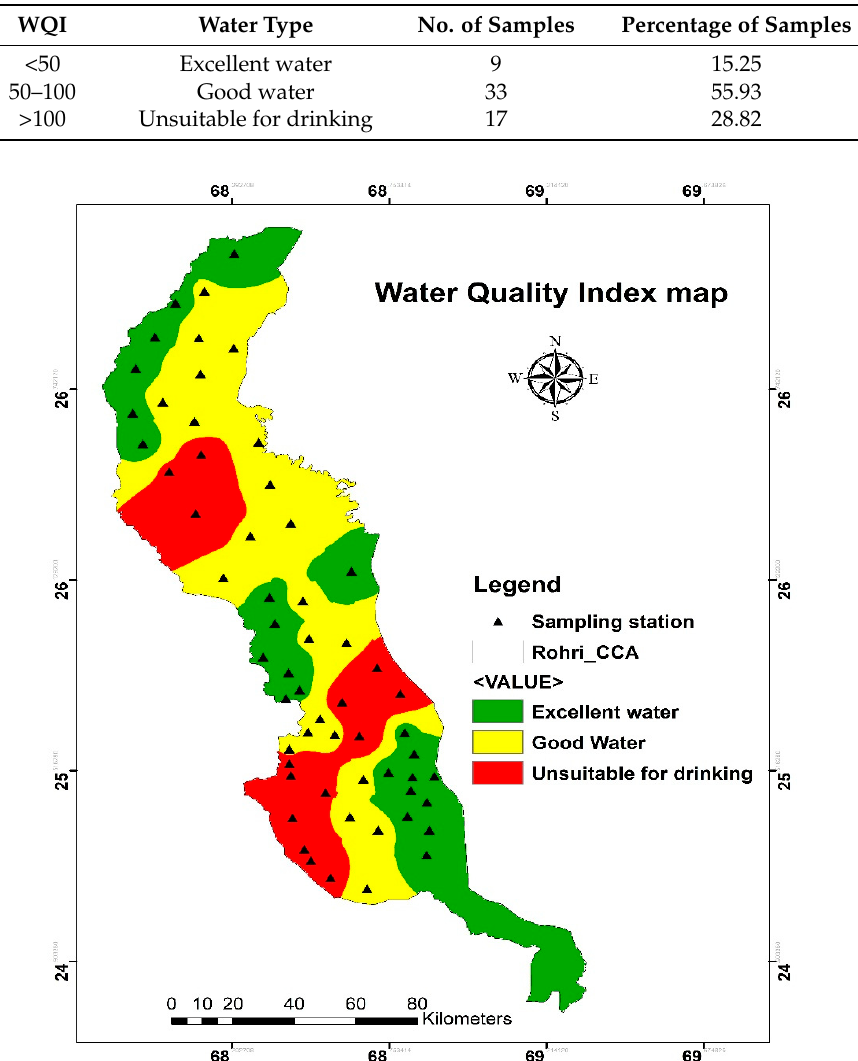
Figure 9. Water Quality Index map.